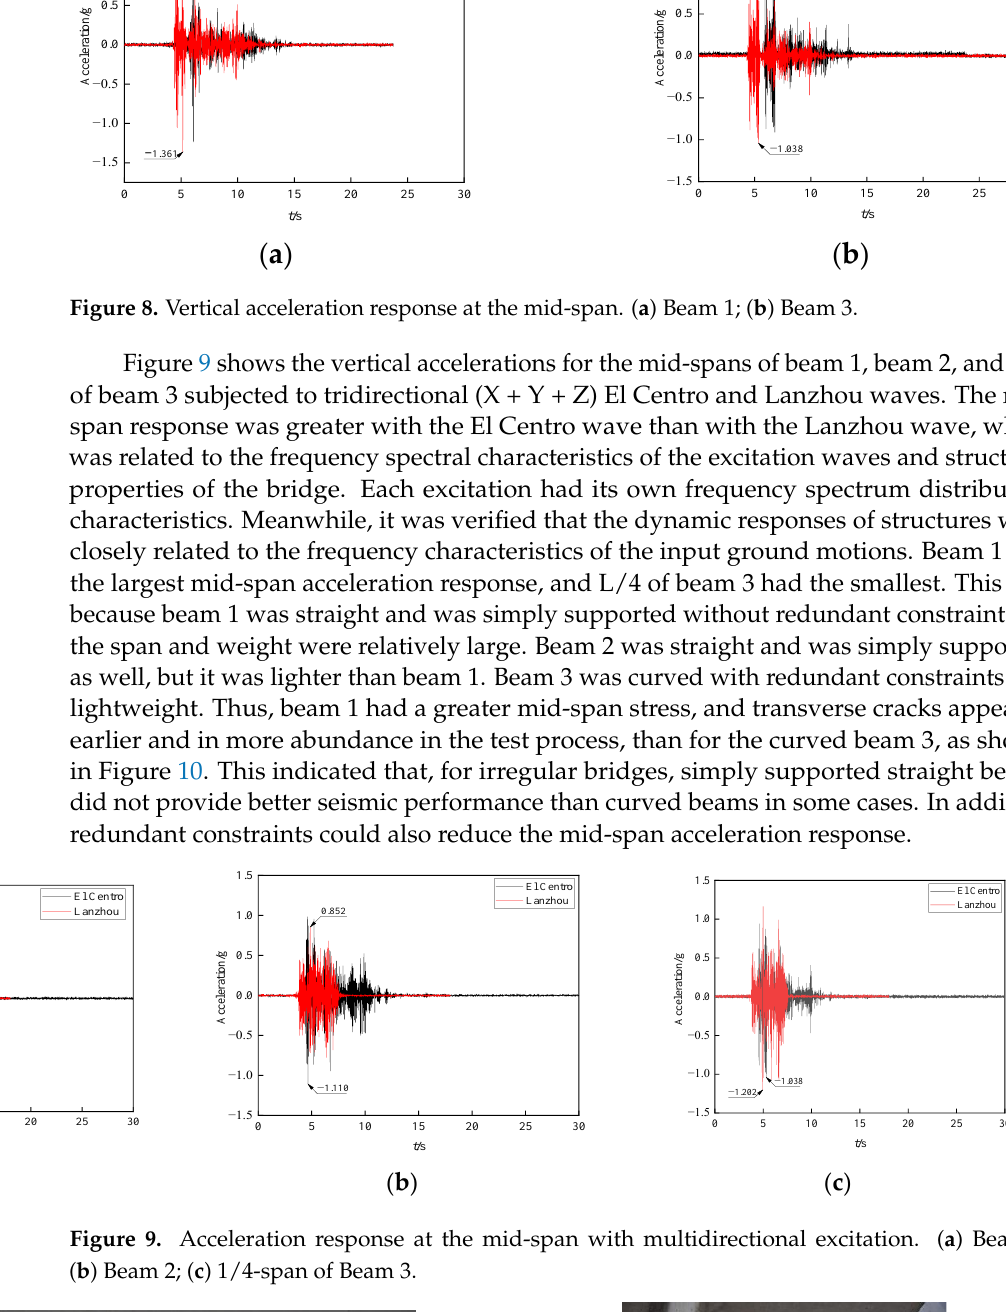
10 of 16 Table 5. Peak acceleration response of the pier top under multidirectional excitation ( g ). Waves